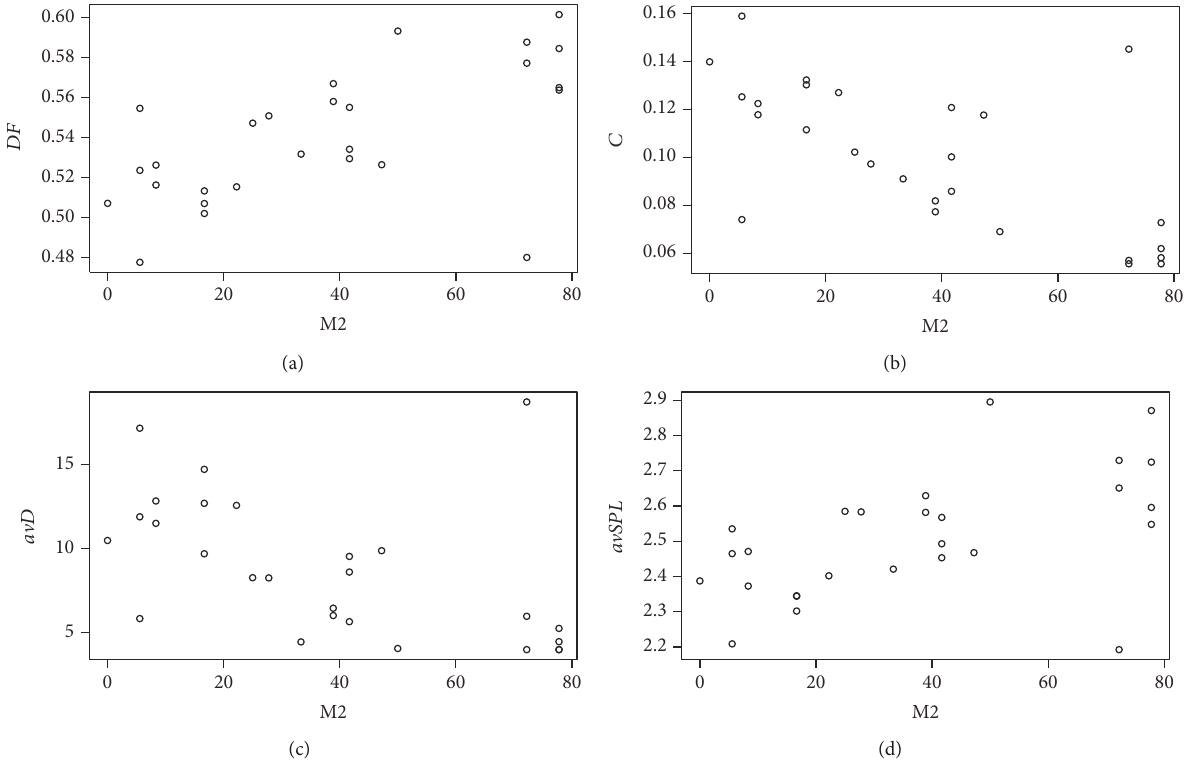
Figure 2: Signi fi cant correlations between topological properties and reachability. DF (a; rho =0.681; p = 0 0009 ), C (b; rho = − 0.678; p = 0 001 ), avD (c; rho = − 0.637; p = 0 00035 ), and avSPL (d; rho =0.605; p = 0 00084 ) versus M2. All of them are strongly signi fi